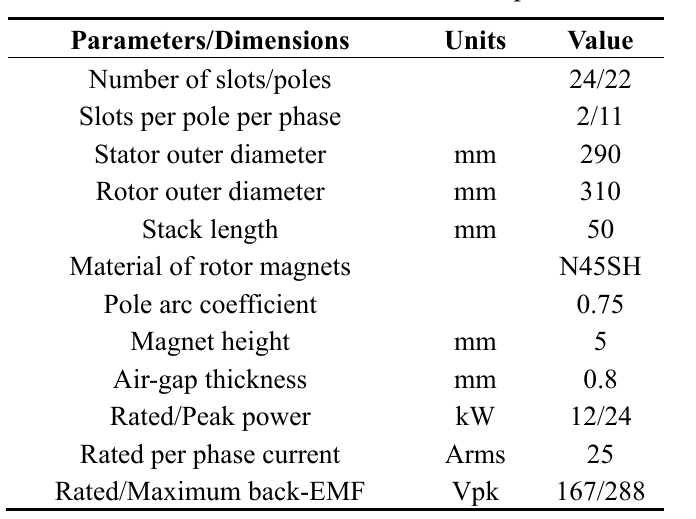
Table 4. Key parameters and dimensions of the 24-slot/22-pole all-teeth-wound